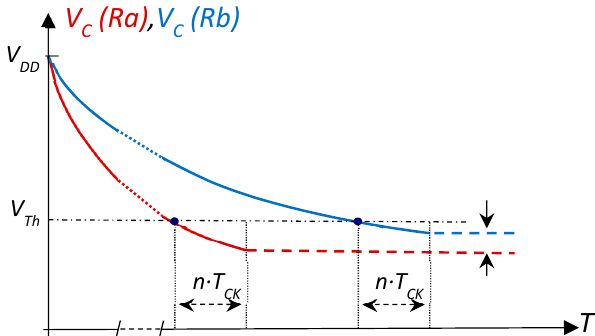
Figure 2. The C discharge process through two different resistors, Ra and Rb (curves V C (Ra) and V C (Rb) ) ends in different voltages due to the prolongation of the discharge for a certain number of clock cycles, n·T CK .